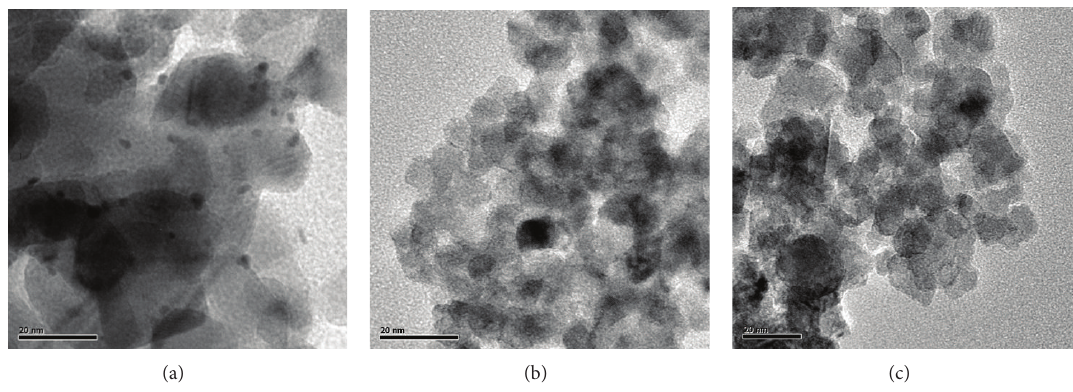
Figure 1: TEM micrographs for (a) Pt/TiO 2 -H 2 , (b) Pt/TiO 2 -air, and (c) TiO 2